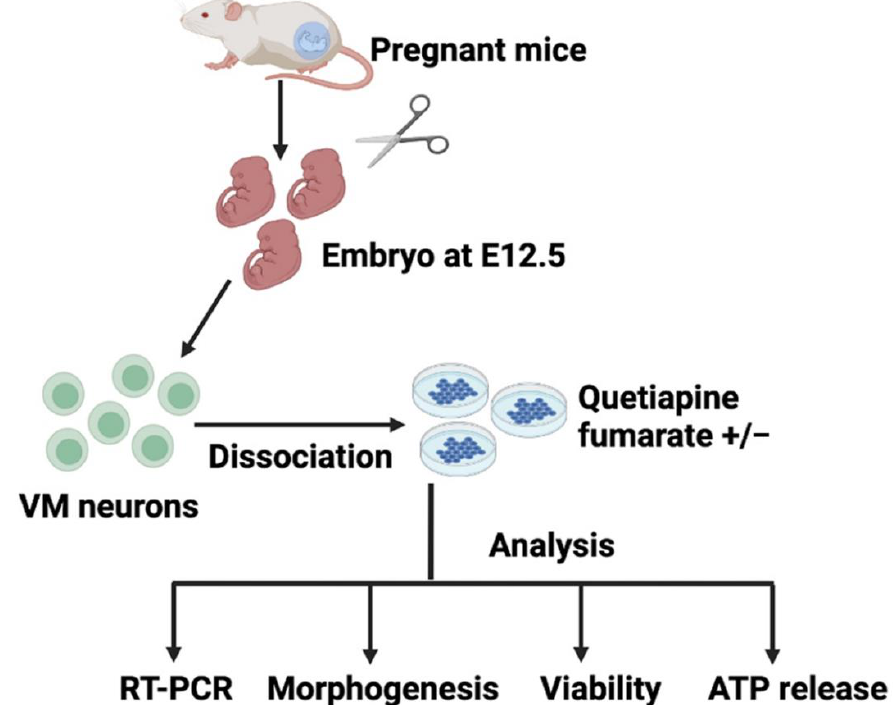
Figure 5. Flowchart depicting the experimental design of this study. VM (Ventral midbrain), RT-PCR (Real-Time PCR), ATP (Adenosine triphosphate).